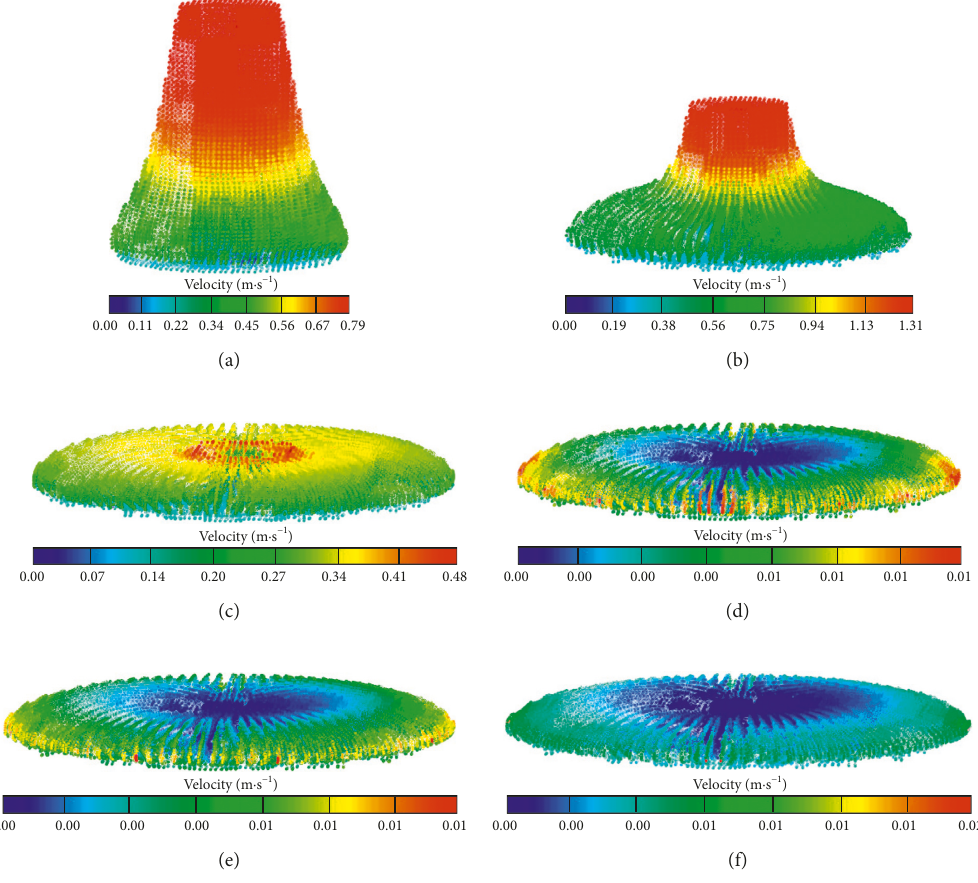
Figure 4: The velocity distribution during the slump test. (a) t � 0.1s, (b) t � 0.2s, (c) t � 0.3s, (d) t � 0.5s, (e) t � 1.0s, and (f) t � 2.0